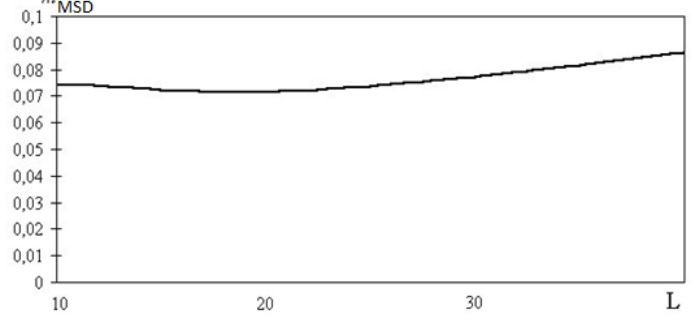
Fig. 5. Dependence m MSD   f L  for the Gaussian law of the distribution of the additive noise component.